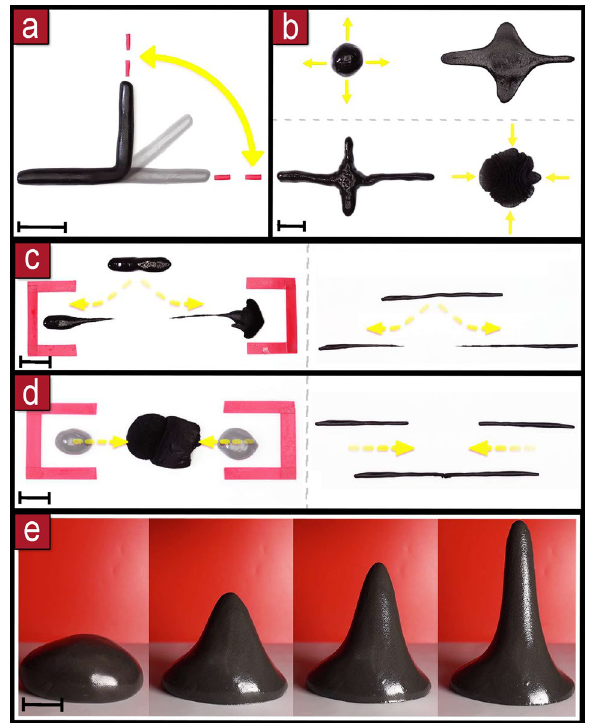
Figure 3. Basic manipulations. (a) Bending and unbending. b) Stretching and contracting. (c) Splitting. (d) Merging. (e) Rising. Scale bars are 3